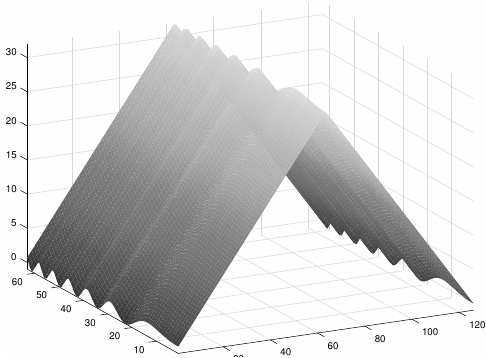
Figure 1. A symmetrically extended